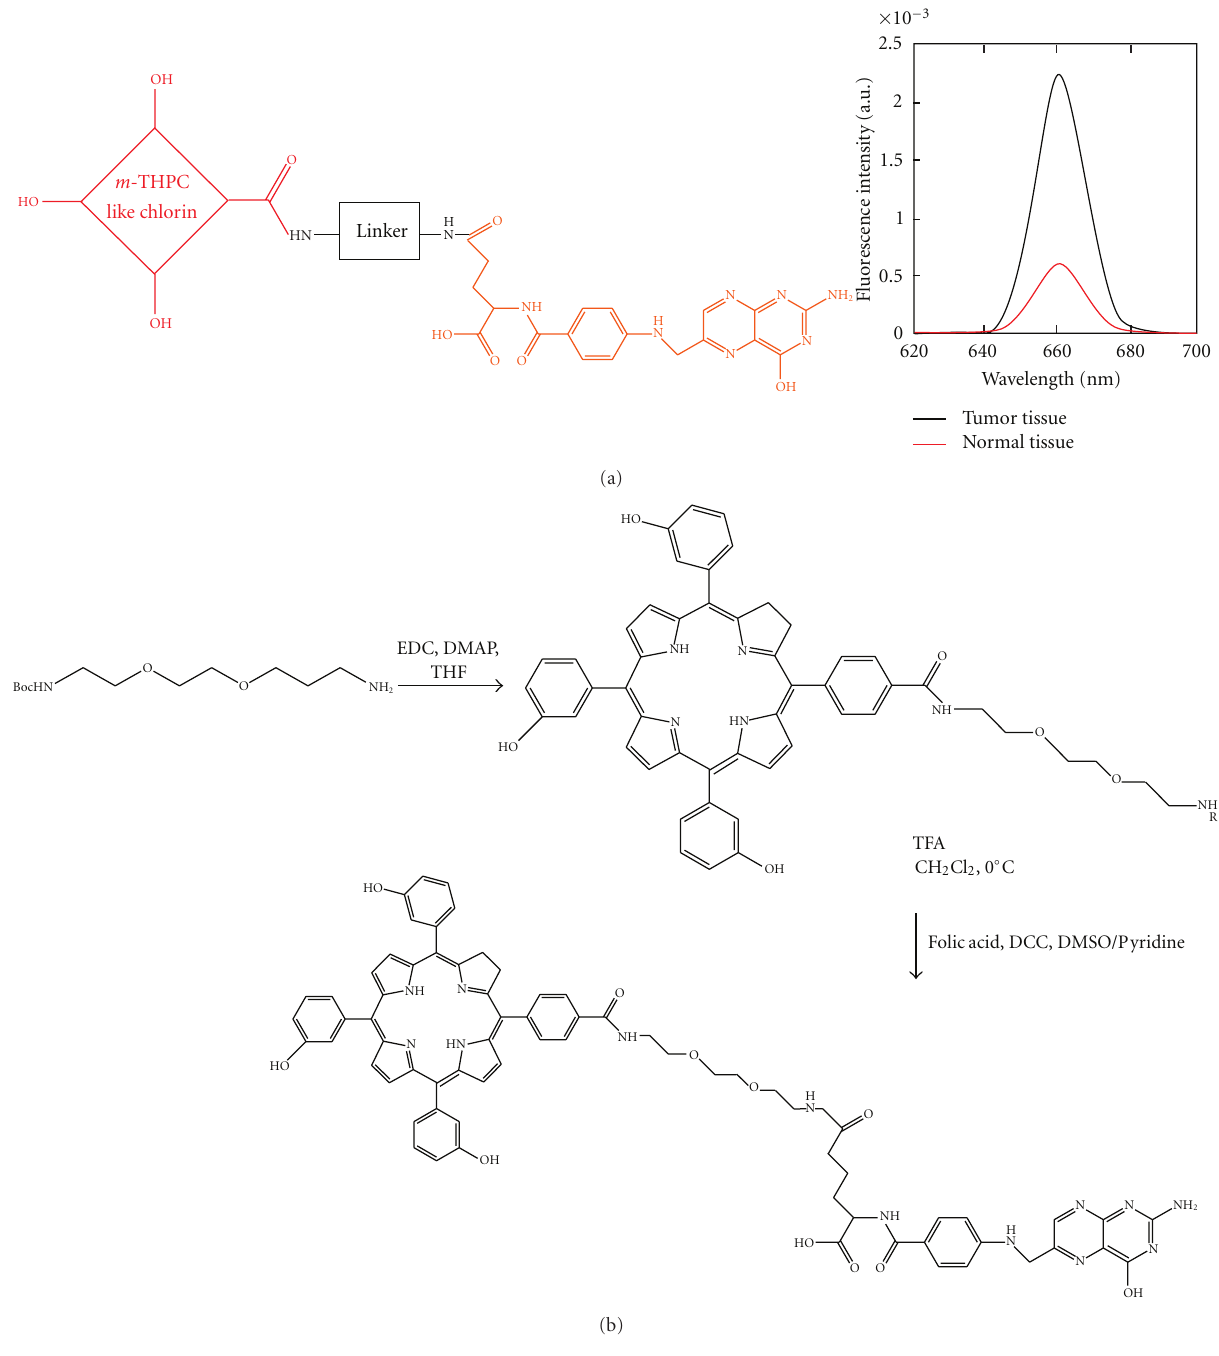
Figure 3: Chemical synthetic method and target specificity of folate conjugate with chlorin-based tris(3-Hydroxyphenyl)-4-carboxy- phenylchlorin